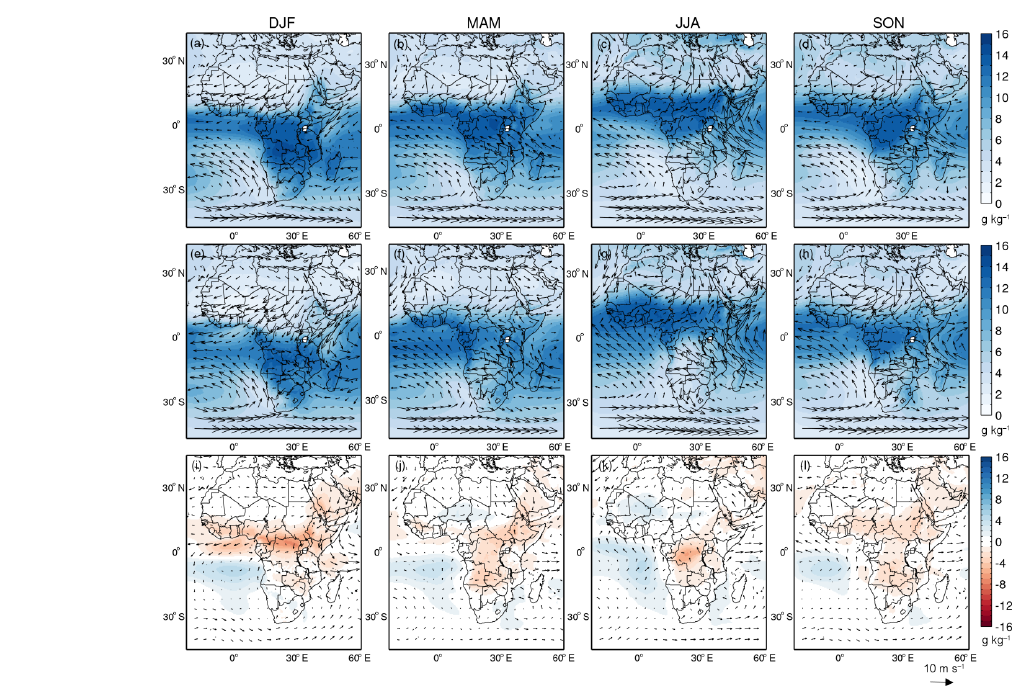
Figure A2. Seasonal atmospheric circulation (arrows, ms − 1 ) and specific humidity (colour contours, gkg − 1 ) at 850hPa pressure level from ERA-Interim (first row), the NFB run (second row), and their differences (third row, NFB minus ERA-Interim) for the period 1997–2010.